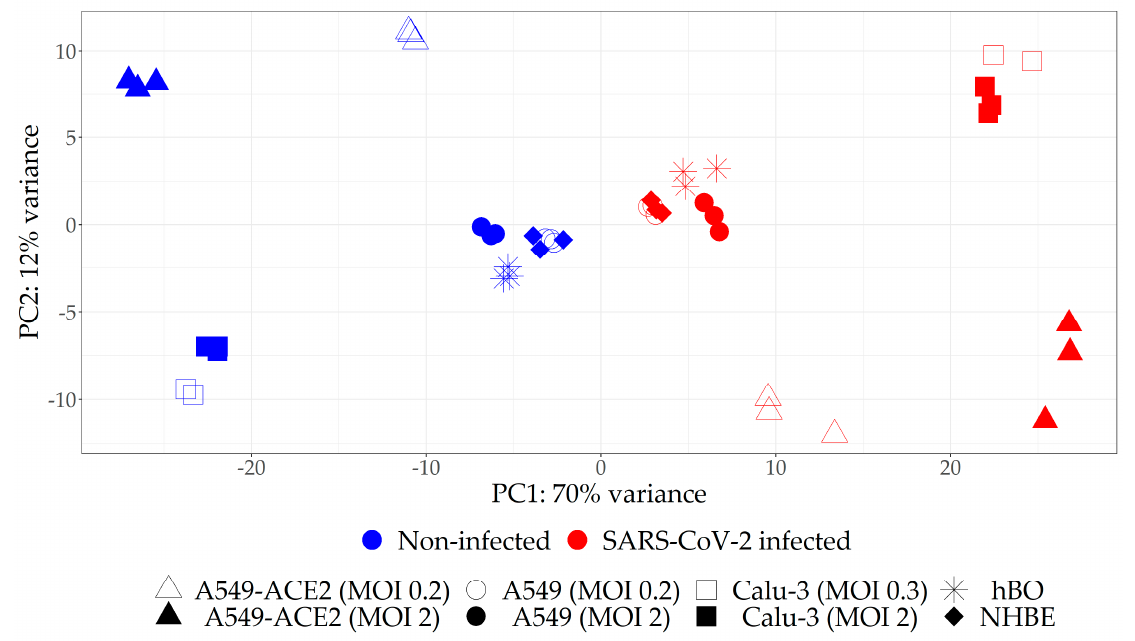
Figure 2. The PCA score plot of all included transcriptomic datasets indicating that A549-ACE2 and Calu-3 cells were more responsive to SARS-CoV-2 infection relative to A549 cell line without ACE2 overexpression, hBO as well as NHBE cells.